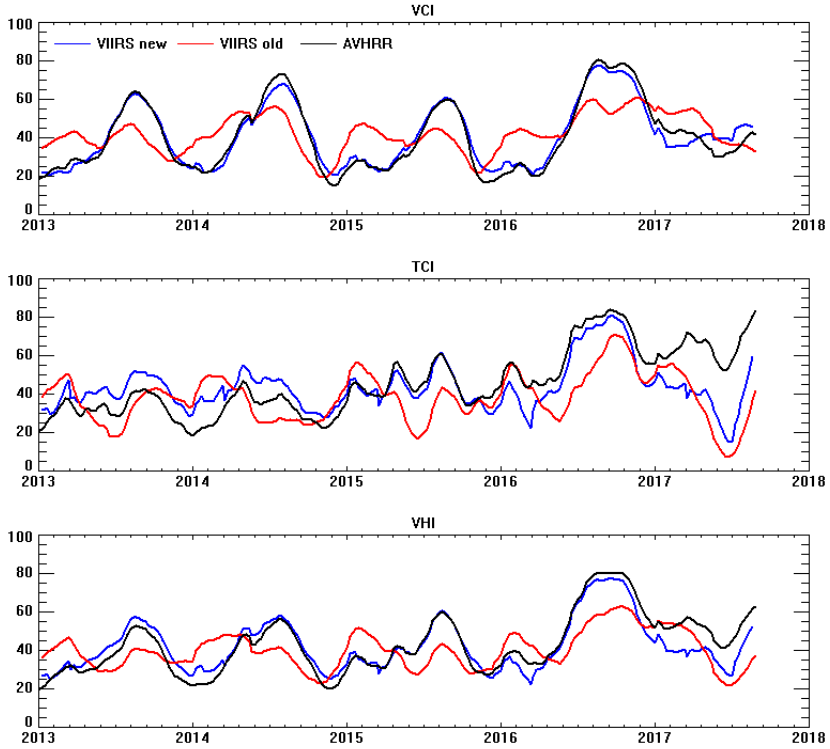
Figure 5. Vegetation health time series of Australian, averaged from five wheat regions weighted by their corresponding areas, from January 2003 to September 2017.